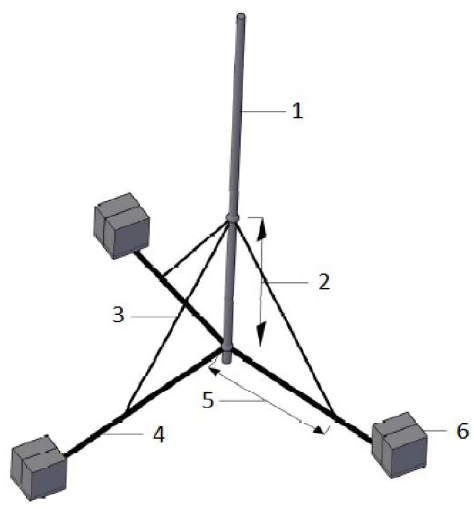
Figure 6. The bearing support for the mast: 1. mast; 2. height of fastening system; 3. brace; 4. bearing support branch; 5. length of fastening system; 6. concrete blocks.